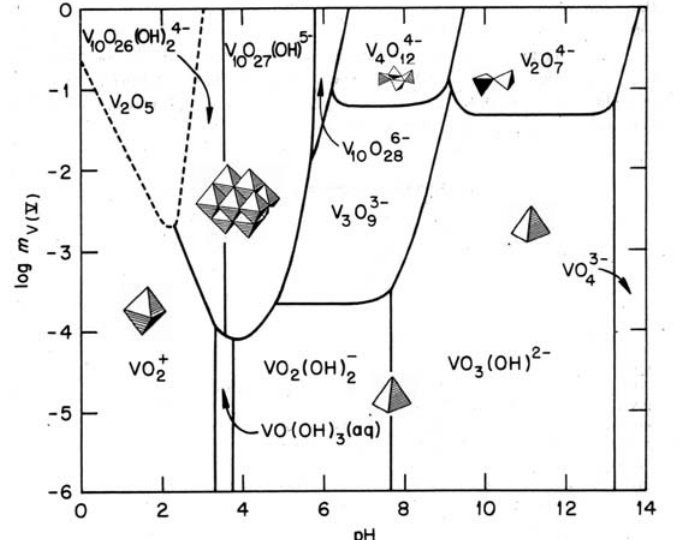
Figure 1. V(V) solute species in aqueous solutions as a function of pH and